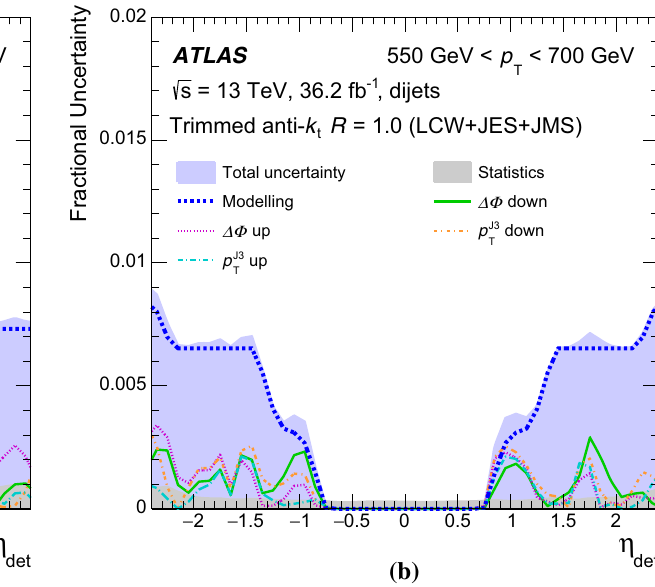
using a filter with a sliding Gaussian kernel across η det yields a smooth function of jet p T and η det . The inverse of this smooth function is taken as the η -intercalibration correction factor c rel ( p T , η det ) , which is applied as a jet four-momentum scale